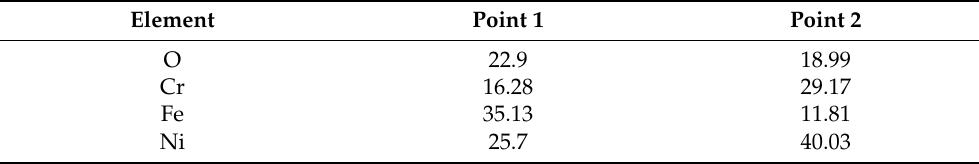
Figure 4. The magnified surface morphologies indicted in the rectangle area of the fouling layer at different positions of the SG tube observed by SEM with a high magnification after 500 h of immersion at 290 ◦ C; ( a ) position 1, ( b ) position 2. Table 4. EDS point analysis at different points in Figure 3b.